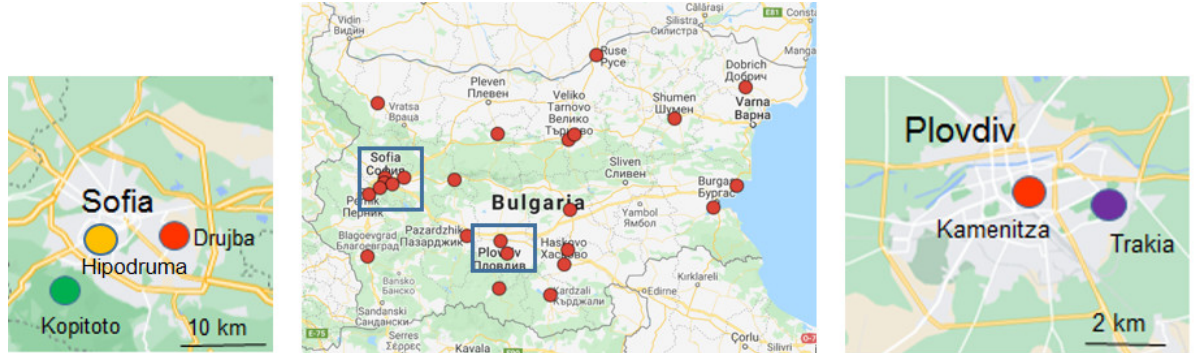
Figure 4. AQ stations (background urban type) used for model evaluation in Bulgaria ( middle panel) with zoom for Sofia ( left panel) and Plovdiv ( right panel). The dots in the zoomed panels indicate stations Sofia-Drujba (BG0052A), Sofia-Kopitoto (BG0070A), Sofia-Hipodruma (BG0050A), and Plovdiv-Kamenitza (BG0051A), for which graphical representation used to compare BgCWFS results to observational data is shown later; Plovdiv-Trakia (BG0078A) (traffic station) was used for LAQMS results.